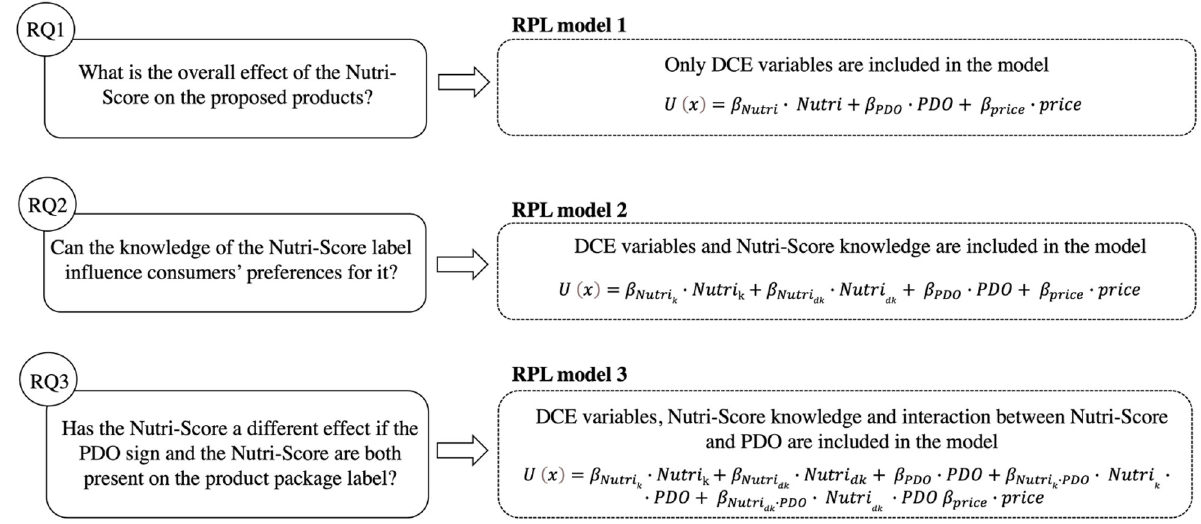
Fig 3. Model specification. Note . Research questions are reported within the continuous line figures. Specifications of the models that allow to address the RQs are shown, respectively, in the dashed line figures. Source . Our elaboration.